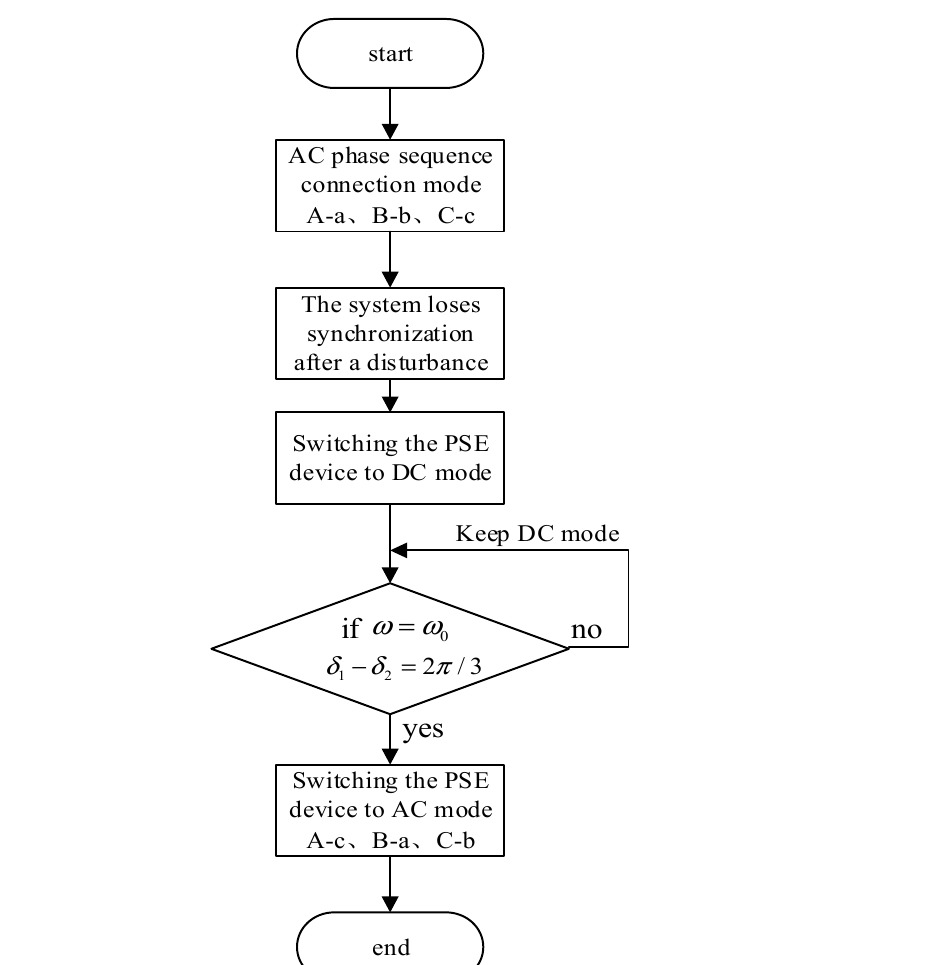
jIx 1 jIx 2 Figure 14. System voltage phasor diagram. By referring to the previous analysis, the MMC-based PSE device can restore the sta-